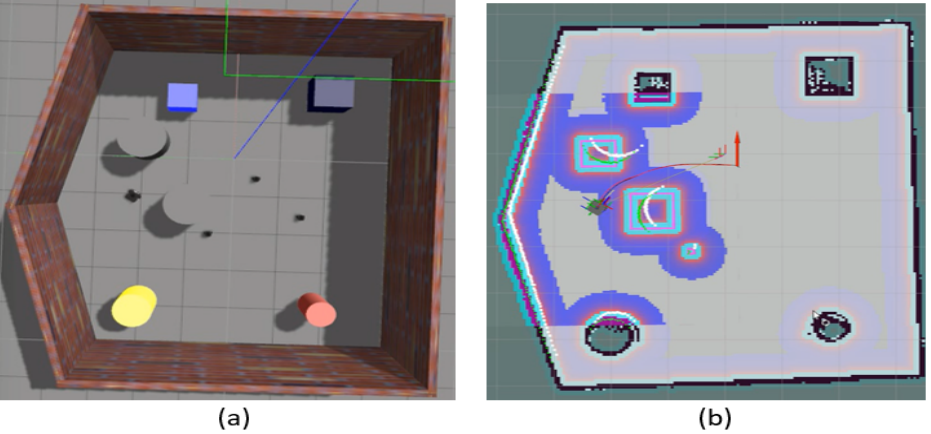
Figure 5. Simulation results of the clustering algorithm: ( a ) A virtual world for robot and obstacle avoidance simulation, ( b ) the robot and obstacles are represented in the cost map layer.